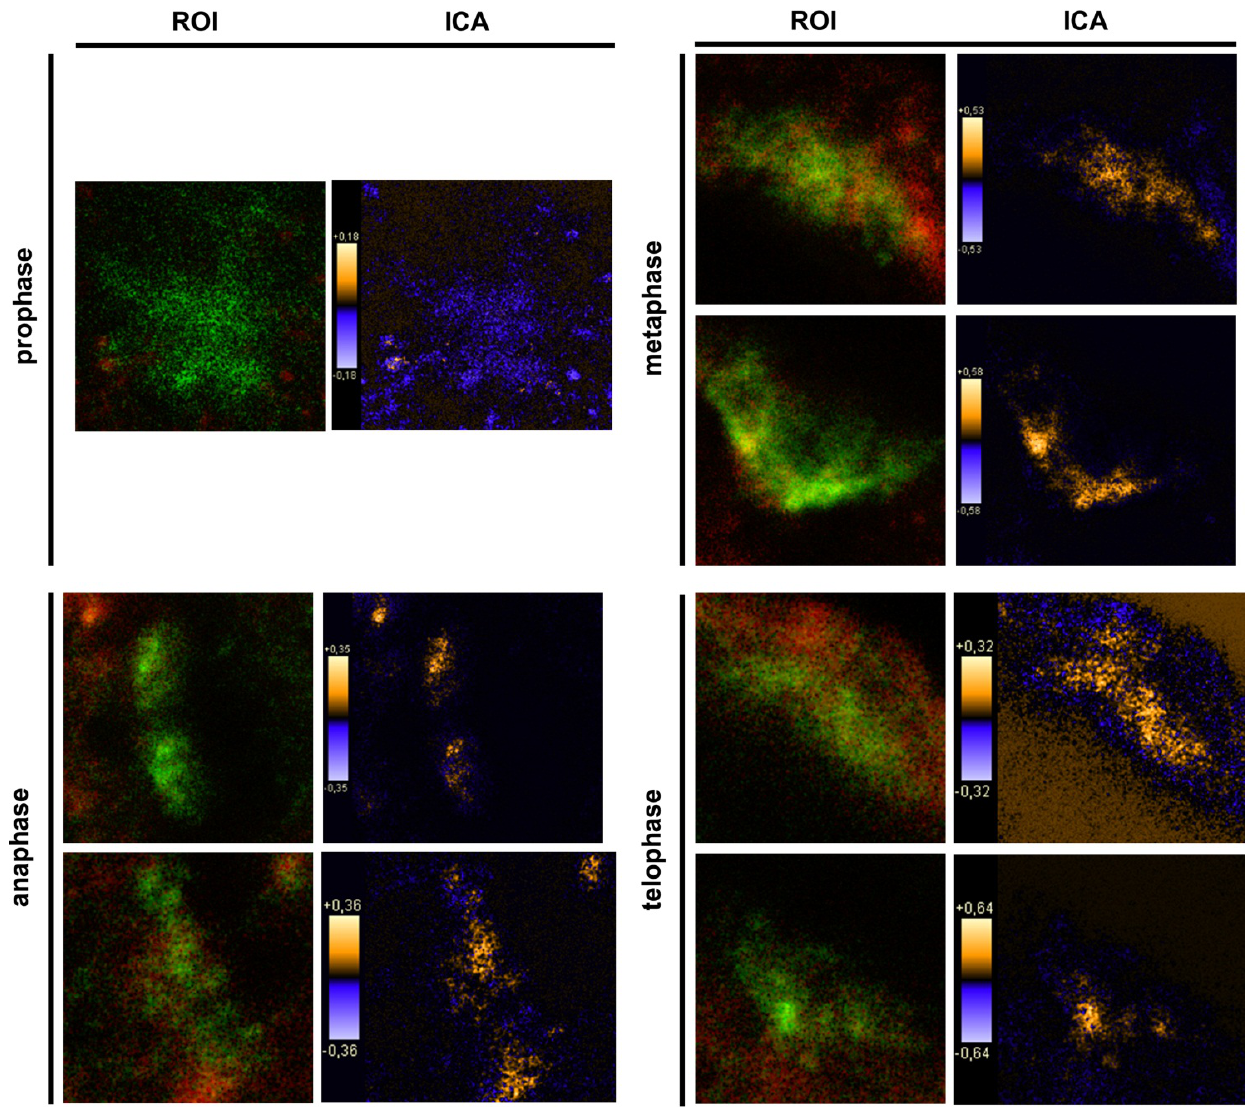
Figure 7. Intensity correlation analysis (ICA) of tyrosine 176 phosphorylated PTPIP51 and tubulin in mitotic cells. Region of interest (ROI) was set to the tubulin staining of each cell of Figure 5C. The co-localization of pTyr-PTPIP51 and tubulin is displayed in orange. Sites of non-co-localization are marked in